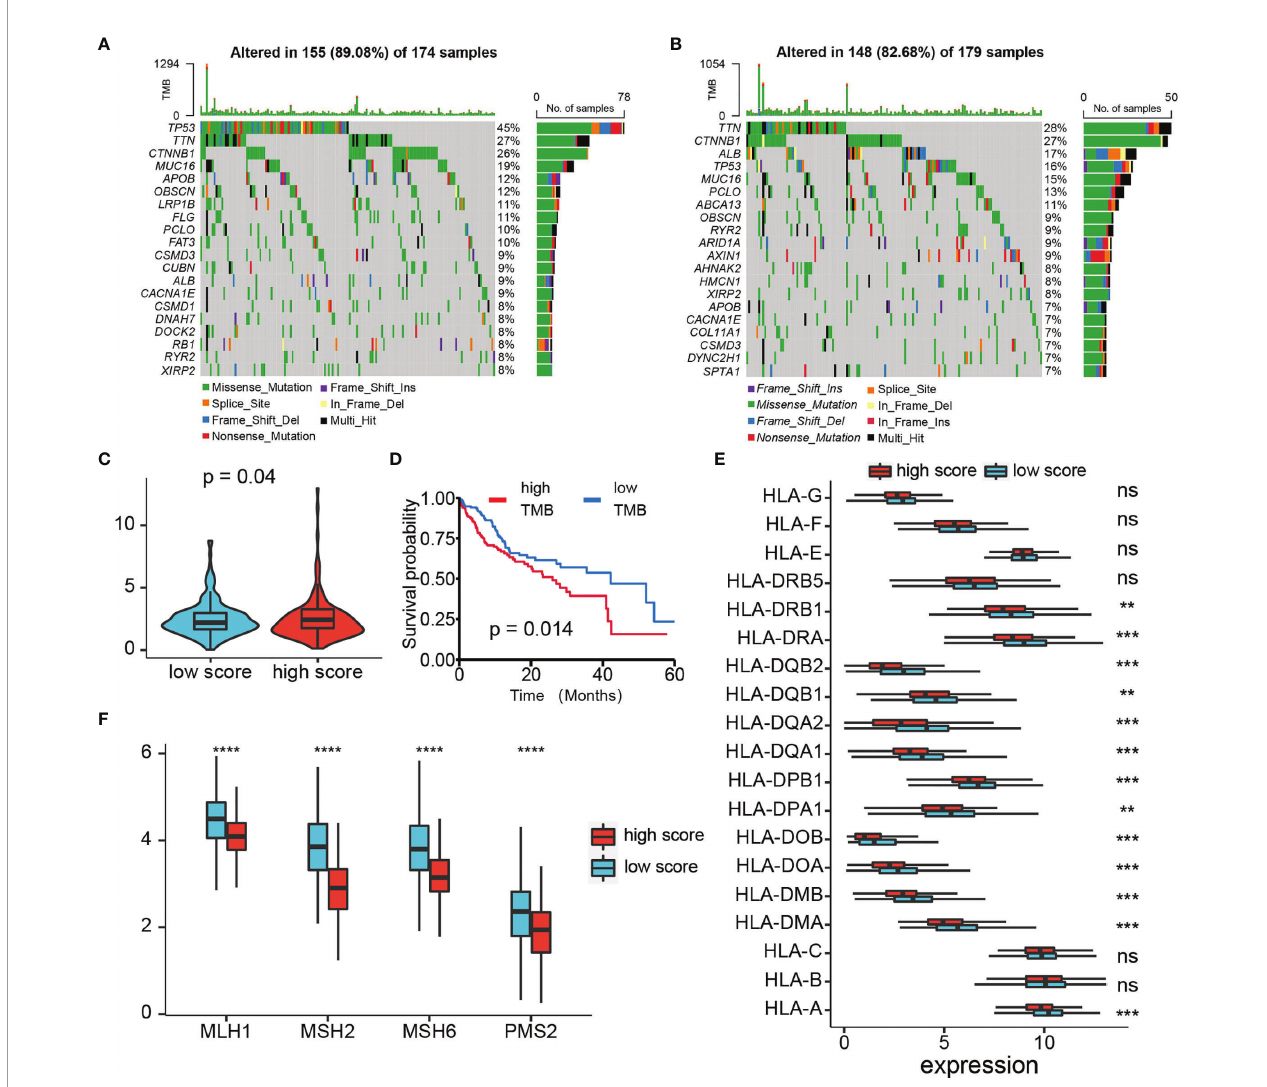
FIGURE 9 | Analysis of TMB, MMR, and HLA expression. (A, B) Top 15 gene mutations in high- and low-risk tumors. (C) Box plot of TMB of HCC patients between high- and low-risk groups. (D) Kaplan – Meier plot of overall survival for patients in high- and low-TMB groups. (E) The pro fi le of HLA genes expression levels in high- and low-risk groups. (F) The pro fi le of MMR-related genes expression levels in high- and low-risk groups. ns p > 0.05, ** p < 0.01, *** p < 0.001, **** p <